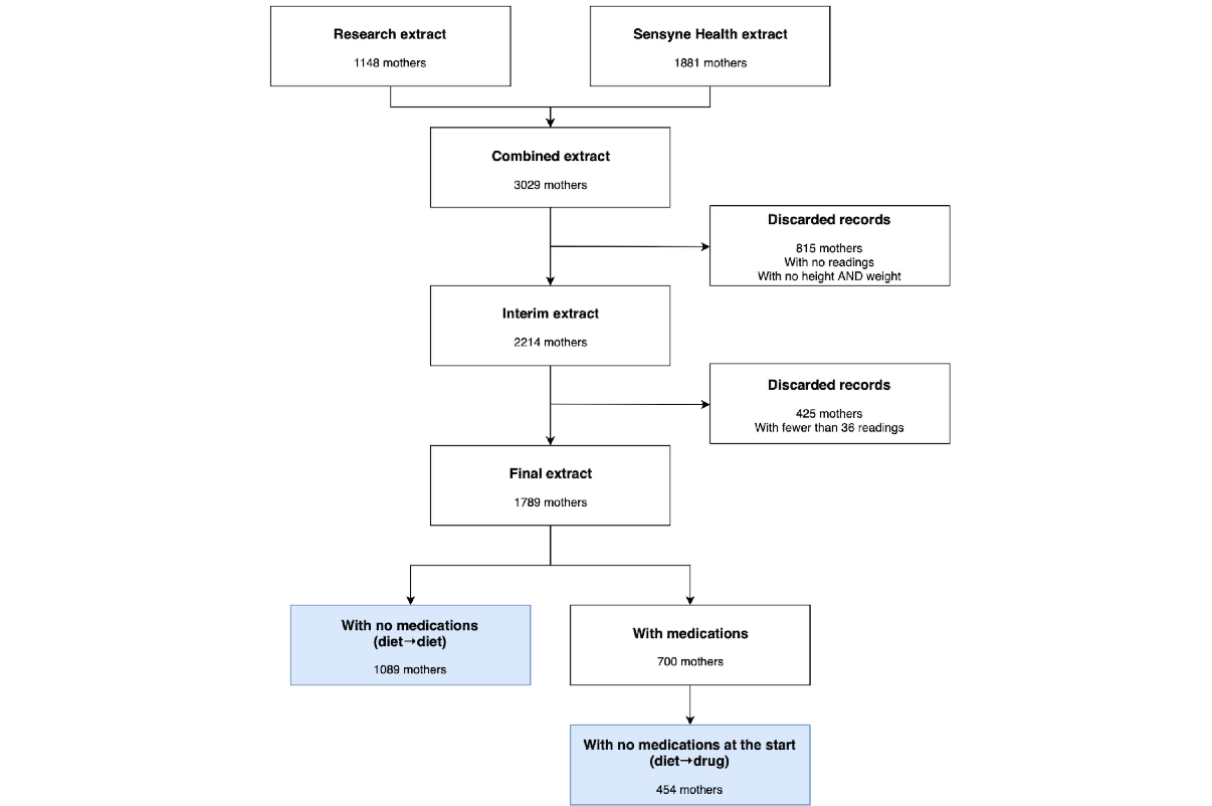
Figure 5. Consort diagram describing the data selection flow. Final groups are identified by the colored